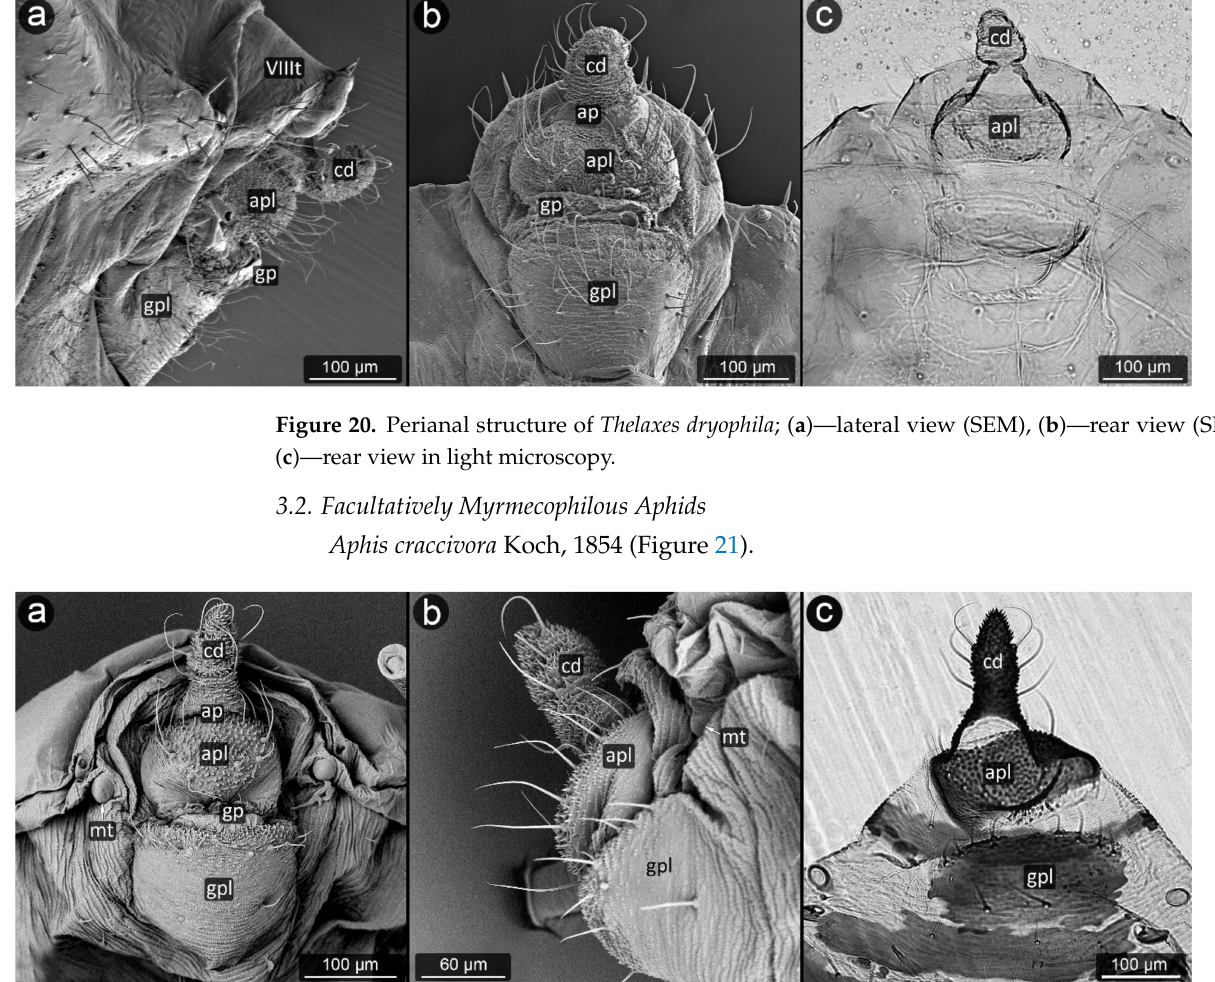
Figure 21. Perianal structure of Aphis craccivora ; ( a )—rear view (SEM), ( b )—lateral view (SEM), ( c )— rear view in light